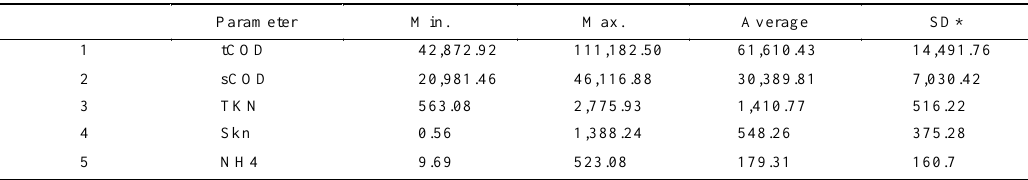
Table 2: Values of the monitored parameters in the fermentation (mg/L)